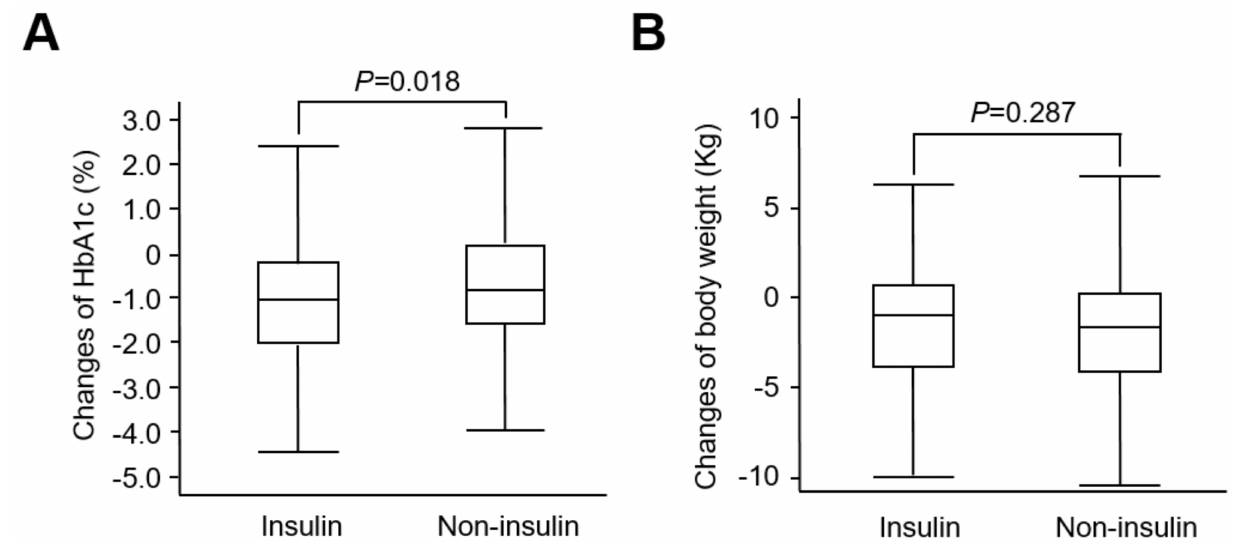
Figure 1. The comparisons of HbA1C ( A ) and body weight ( B ) changes from baseline to 12 months between the insulin and non-insulin users.